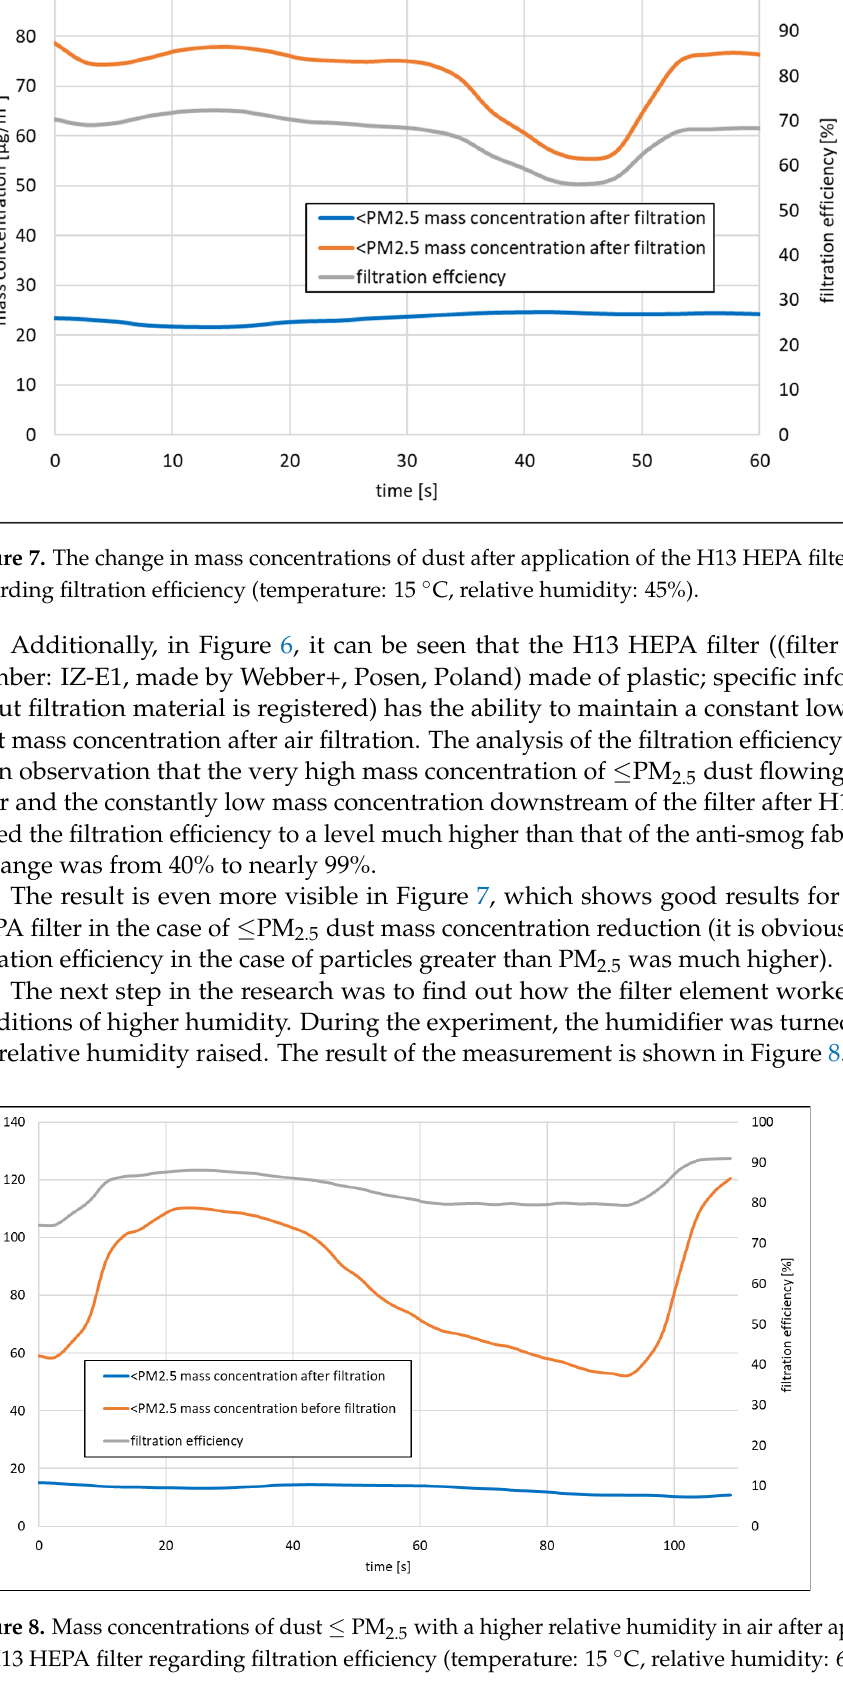
ber: IZ ‐ E1, made by Webber+, Posen, Poland) made of plastic; specific information about